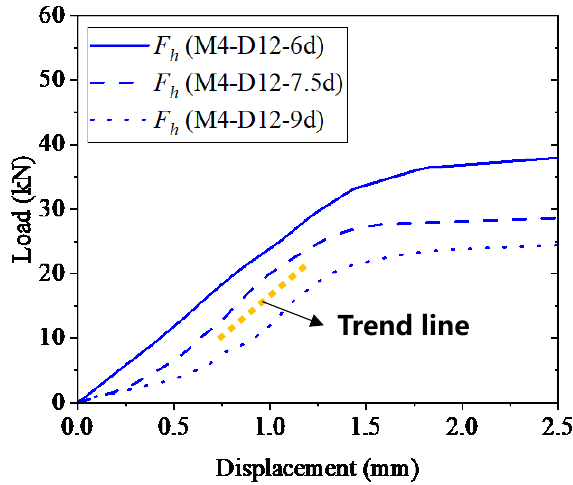
Figure 19. Comparison of head bearing among specimens with different lap length.